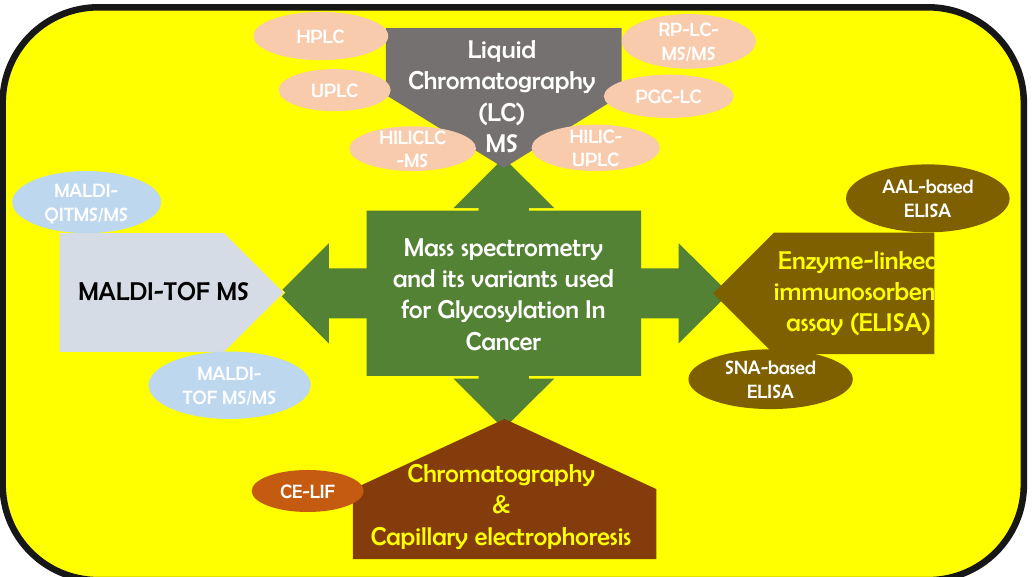
Figure 1. Mass spectrometry and its variants that have been reported to be used to analyze glycan-based cancer biomarkers.